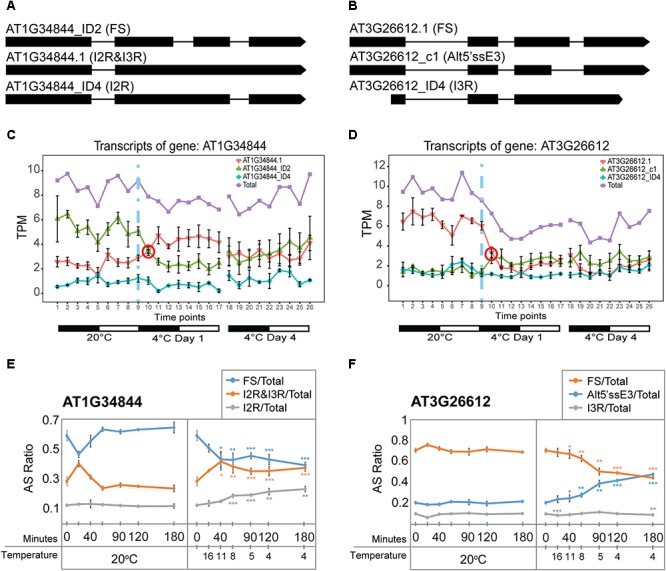
Rapid cold-induced alternative splicing of lncRNAs. (A) Transcript structures of AT1G34844 isoforms showing the fully spliced transcript (AT1G34844_ID2), AT1G34844.1 which retains introns 2 and 3, and AT1G34844_ID4 which retains intron 2. (B) Transcript structures of AT3G26612 isoforms showing the fully spliced transcript (AT3G26612.1), AT3G26612_c1 which has an alternative 5′ splice site in exon 3, and AT3G26612_ID4 which retains intron 3. (C) AT1G34844 is regulated by alternative splicing only. AT1G34844_ID2 and AT1G34844.1 show a transient decrease and increase, respectively, between 20°C and day 1 at 4°C while AT1G34844_ID4 remains unchanged throughout the experiment. (D) AT3G26612 is regulated by alternative splicing only. AT3G26612.1 significantly decreases in the first 6 h (day 1) and throughout the cold treatment, while the other two transcripts have similar levels of expression, with AT3G26612_c1 slightly increasing and AT3G26612_ID4 remaining unchanged. (E,F) High-resolution RT-PCR analysis of splicing ratios at 20°C (control – left panels) and decreasing to 4°C (right panels). (E) The fully spliced and I2R&I3R transcripts of AT1G34844 respond rapidly to changes in temperature within 40 min when the temperature reaches 11°C and onward as the temperature decreases further. (F) The fully spliced and Alt5′ssE3 transcripts of AT3G26612 respond rapidly to changes in temperature within 40 min when the temperature reaches 11°C and onward as the temperature decreases further, while I3R is mostly unresponsive. Student’s t-tests were performed to compare each temperature reduction results against 20°C control. Significant differences are labeled with asterisks (∗∗p < 0.01; ∗∗∗p < 0.001).